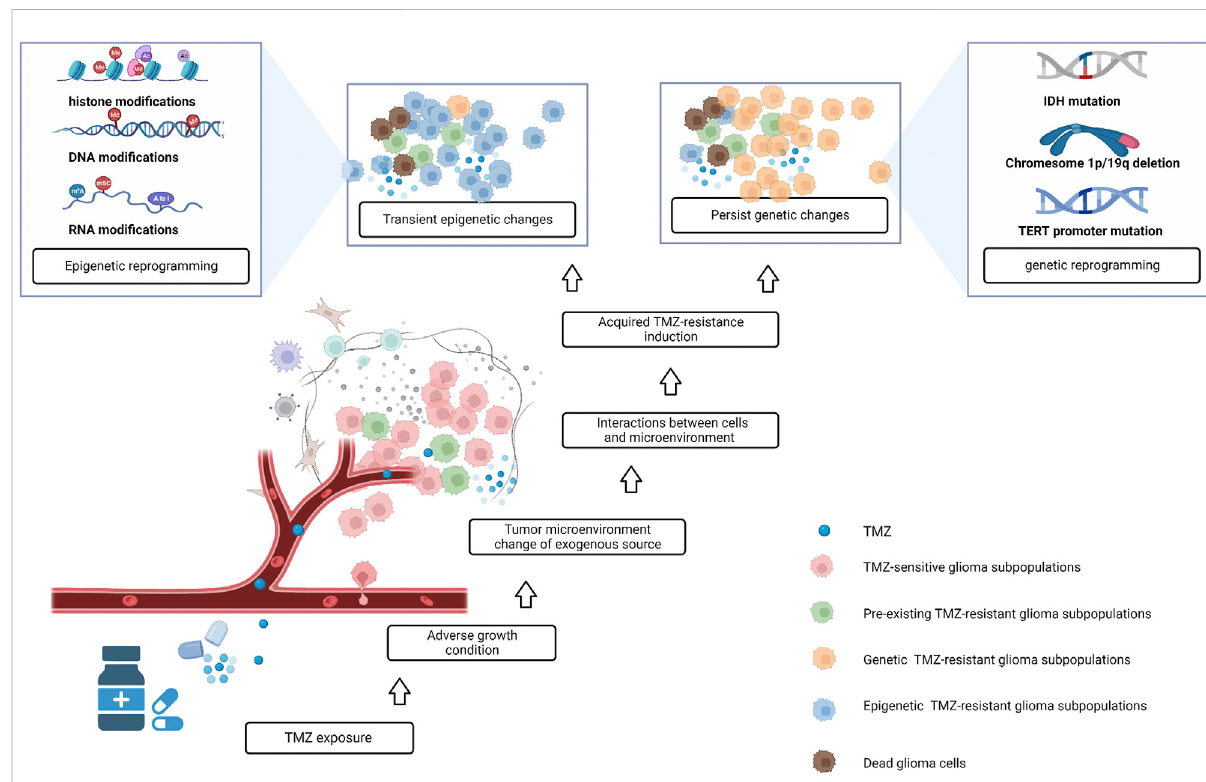
FIGURE 1 The formation of acquired drug resistance in glioma; after treatment with TMZ, some TMZ-sensitive glioma subpopulations die, and pre- existing TMZ-resistant glioma subpopulations have the potential to become dominant. At the same time, some precious TMZ-sensitive tumor cells interact with the tumor microenvironment, which has changed after TMZ exposure, and some of these cells acquire TMZ-resistance via epigenetic and genetic